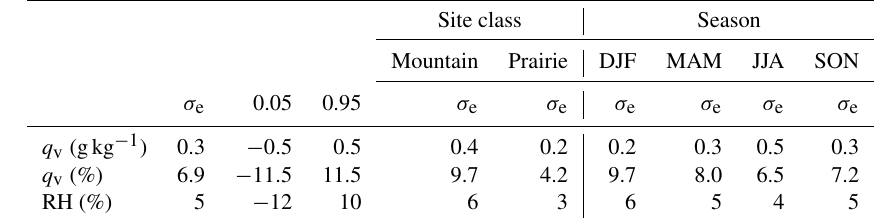
Table 1. Spatial interpolation errors for q v and RH by site class (mountain vs. prairie site) and season. σ e is the standard error (the standard deviation of the error distribution) and 0.05 and 0.95 are the 5th and 95th percentile values of the error.